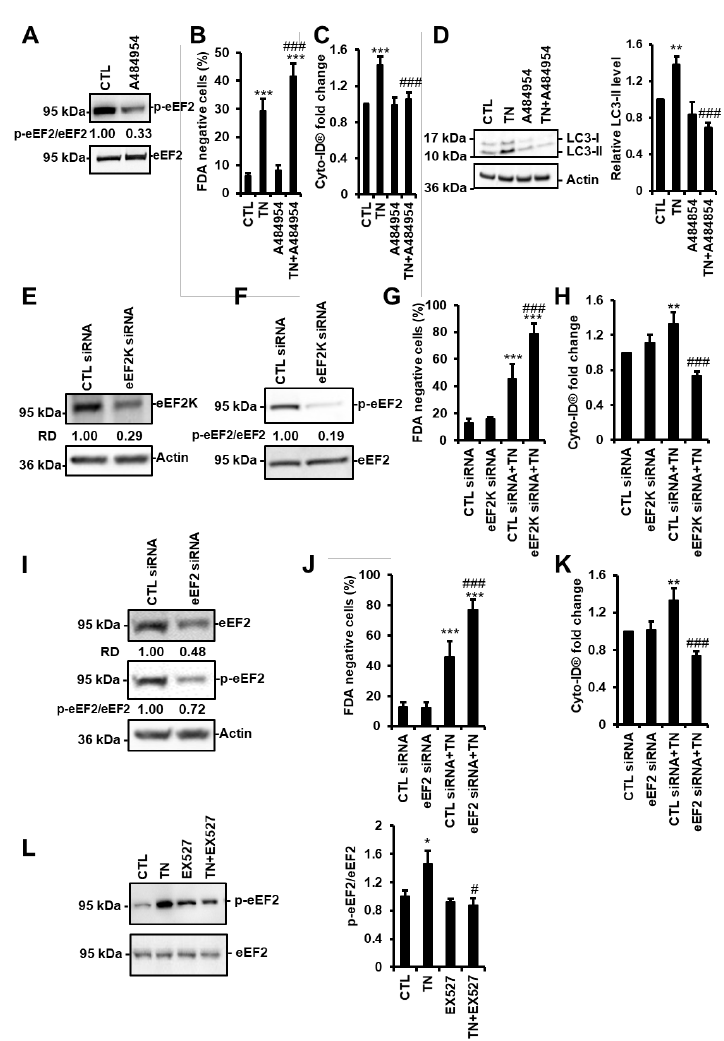
Figure 6. SIRT1 activates eEF2K / eEF2-dependent autophagy in response to ER stress. ( A ) H9c2 cells were treated with 10 µ M A484954 for 4 h (eEF2K inhibitor) and the level of phospho-eEF2 (p-eEF2) was analyzed by Western blot (n = 7). The ratio of p-eEF2 vs. total eEF2 is presented. ( B ) H9c2 cells were left untreated or treated with 10 µ g / mL tunicamycin (TN) for 48 h ± 10 µ M A484954, and cell viability was determined by Fluorescein Diacetate (FDA) assay. Results presented in the bar graph are expressed as mean ± S.E.M. of percentages of dead cells (FDA negative cells, n = 11). ( C ) Autophagy was monitored by flow cytometry after Cyto-ID ® staining of H9c2 cells untreated or treated with 10 µ g / mL tunicamycin (TN) for 24 h ± 10 µ M A484954 (n = 11). ( D ) Cells were left untreated or treated with 10 µ g / mL tunicamycin (TN) for 24 h ± 10 µ M A484954 and the levels of LC3-II were analyzed by Western blot. Actin was used as a loading control. The relative mean expression level of LC3-II is presented in the bar graph. Error bars, S.E.M. (n = 5). ( E , F , I ) H9c2 cells were transfected with control, eEF2K or eEF2 siRNA, and eEF2K ( E ) or eEF2 ( I ) expression and eEF2 phosphorylation ( F , I ) were assessed after 24 h by Western blot. ( G , J ) H9c2 cells were transfected with control, eEF2K ( G ), or eEF2 ( J ) siRNA for 24 h, then treated for 48 h with tunicamycin (TN) and cell death (FDA negative cells) was measured by flow cytometry. Data in the bar graphs represent mean ± S.E.M. (n = 3). ( H , K ) H9c2 cells were transfected with control, eEF2K ( H ) or eEF2 ( K ) siRNA for 24 h, then treated for 24 h with tunicamycin (TN) and autophagy (MFI of Cyto-ID ® ) was measured by flow cytometry. Data in the bar graphs represent mean ± S.E.M. (n = 3). ( L ) phospho-eEF2 expression level was measured by Western blot in H9c2 cells after 4 h of 10 µ g / mL tunicamycin (TN) ± 50 µ M EX527 (SIRT1 inhibitor) treatment. The ratio of p-eEF2 vs. total eEF2 is presented in the bar graph. Error bars, S.E.M. (n = 9). * P < 0.05, ** P < 0.01, *** P < 0.005 versus control. # P < 0.05, ### P < 0.005 versus